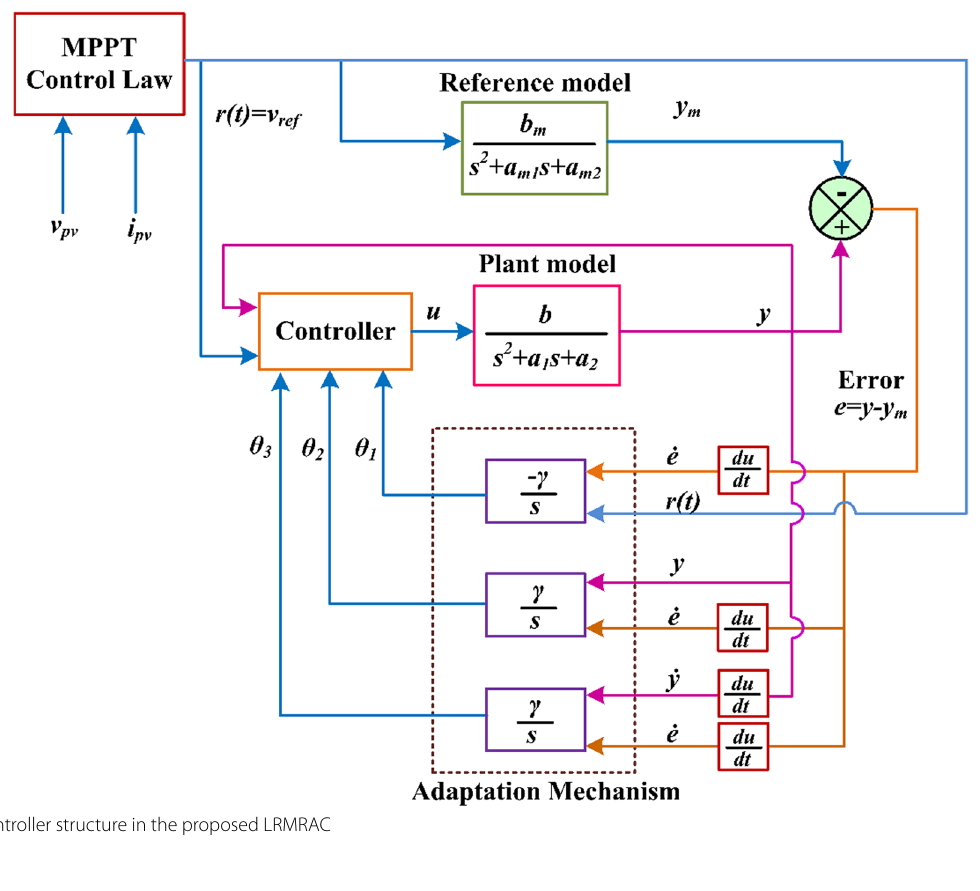
Fig. 11 Controller structure in the proposed